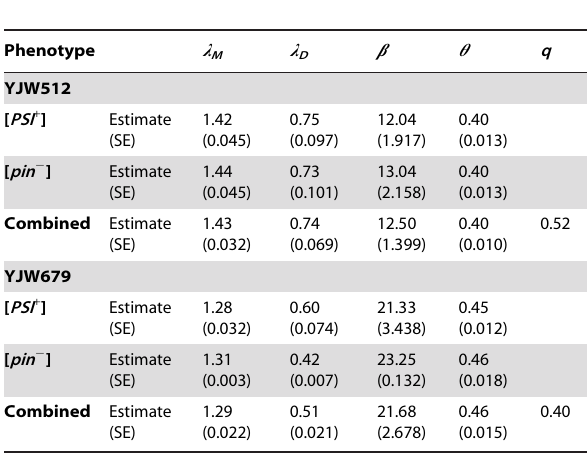
Table 4. Parameter estimates from fitting the mother- daughter gamma distributions to the cell reproduction data